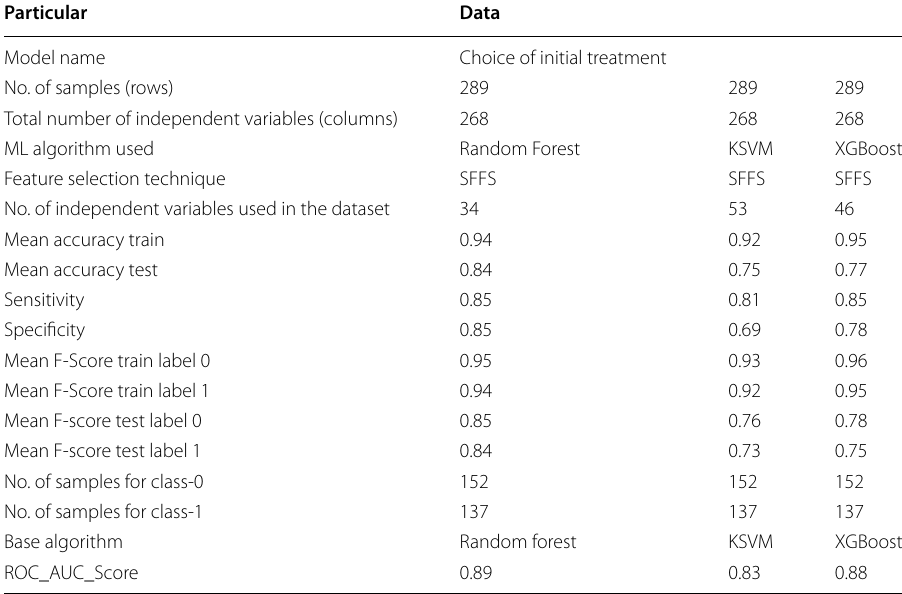
Table 6 Results of test dataset for choice of the initial treatment model